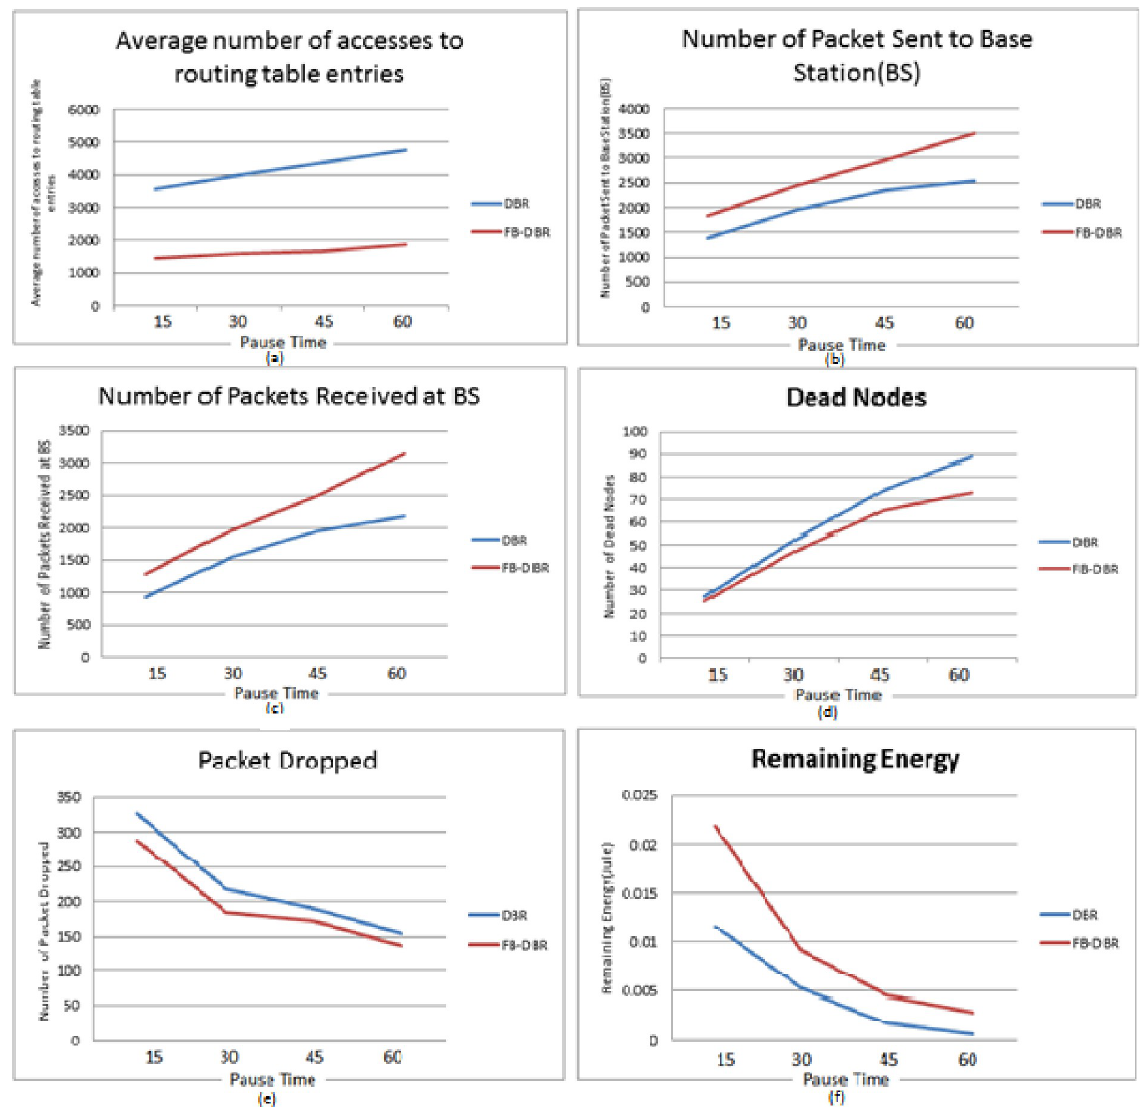
Fig 10. FB-DBR and DBR outputs based on Pause